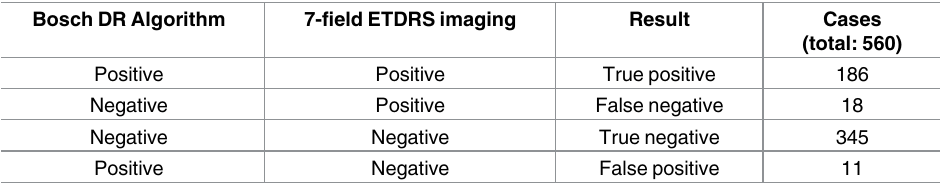
Table 3. Sensitivity and specificity of the Bosch Dr